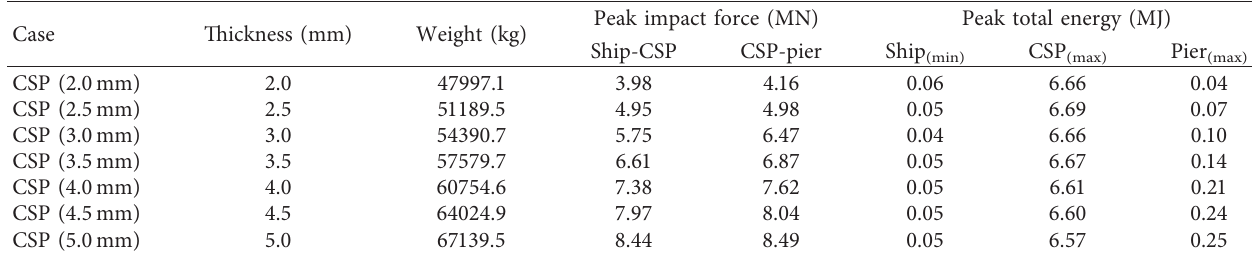
Table 3: Parameters and calculation result